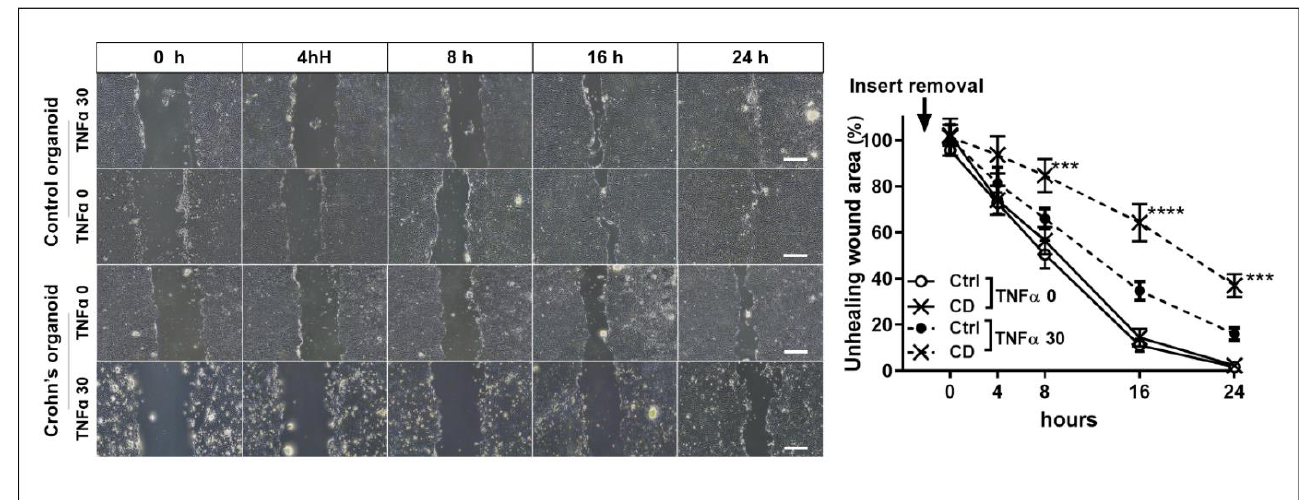
Figure 8. Wound healing assay. Non-healing wound areas in three different areas selected from TNFα-free and -treated organoids derived from controls and CD patients were measured ( n = 3 each). The area of the unhealed wound is expressed in %, based on the observed area of TNFα-free control organoids. Differences were evaluated using two-way ANOVA test with Bonferroni’s multiple comparison test; *** p < 0.001 and **** p < 0.0001. Scale bar = 4 mm.